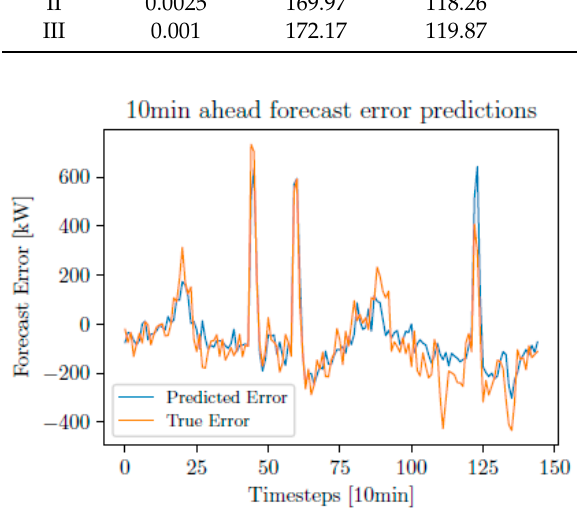
Figure 17. Ten-minutes-ahead error forecasts.